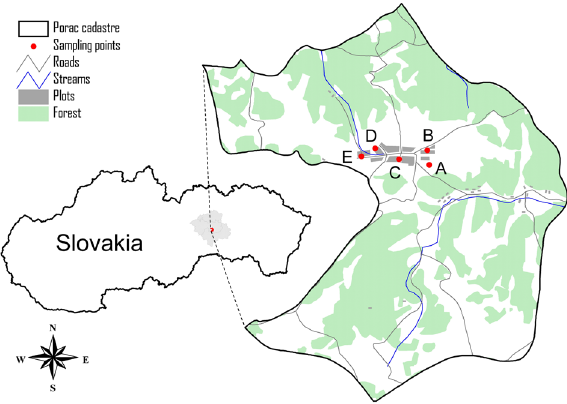
Figure 1. Map of the studied area and sampling